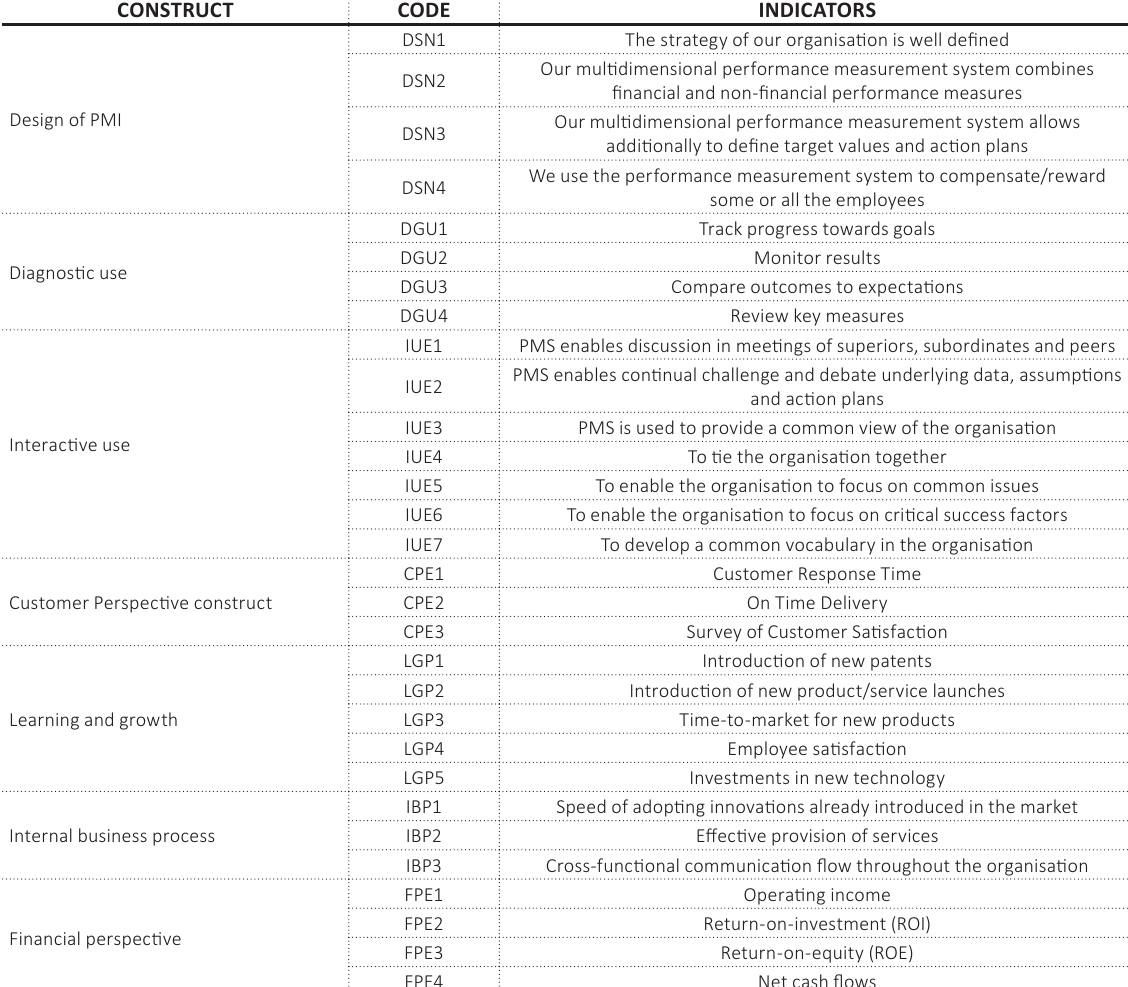
Table A1. List of Indicators in the Final Structural